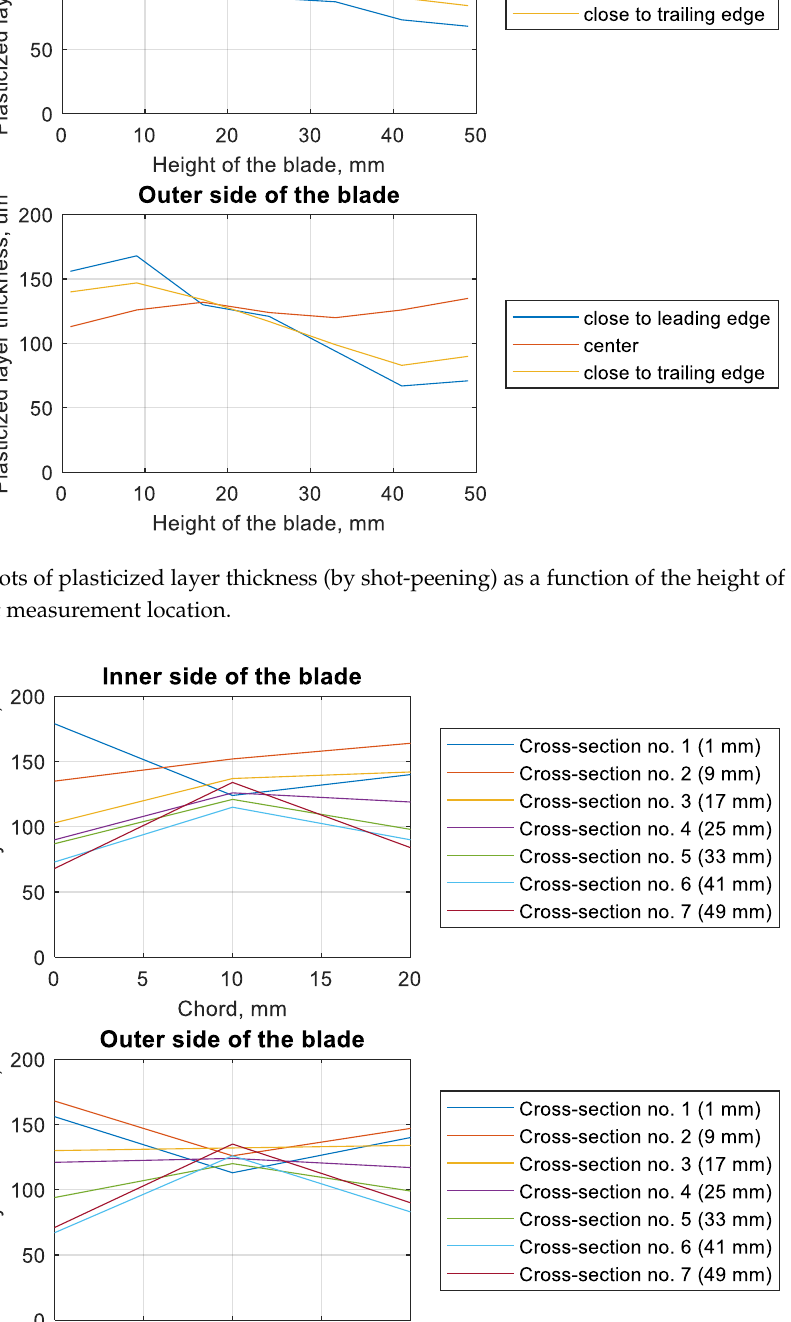
Figure 10. Plots of plasticized layer thickness (by shot-peening) as a function of the chord of the blade for a different side of the blade, for different